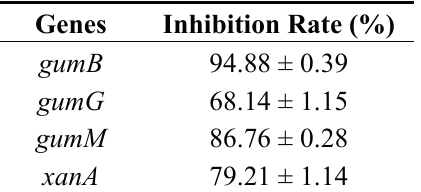
Table 4. Inhibition rates of 2-(methylsulfonyl)-5-(4-fluorophenyl)-1,3,4-oxadiazole on EPS gene expression at 20 μ